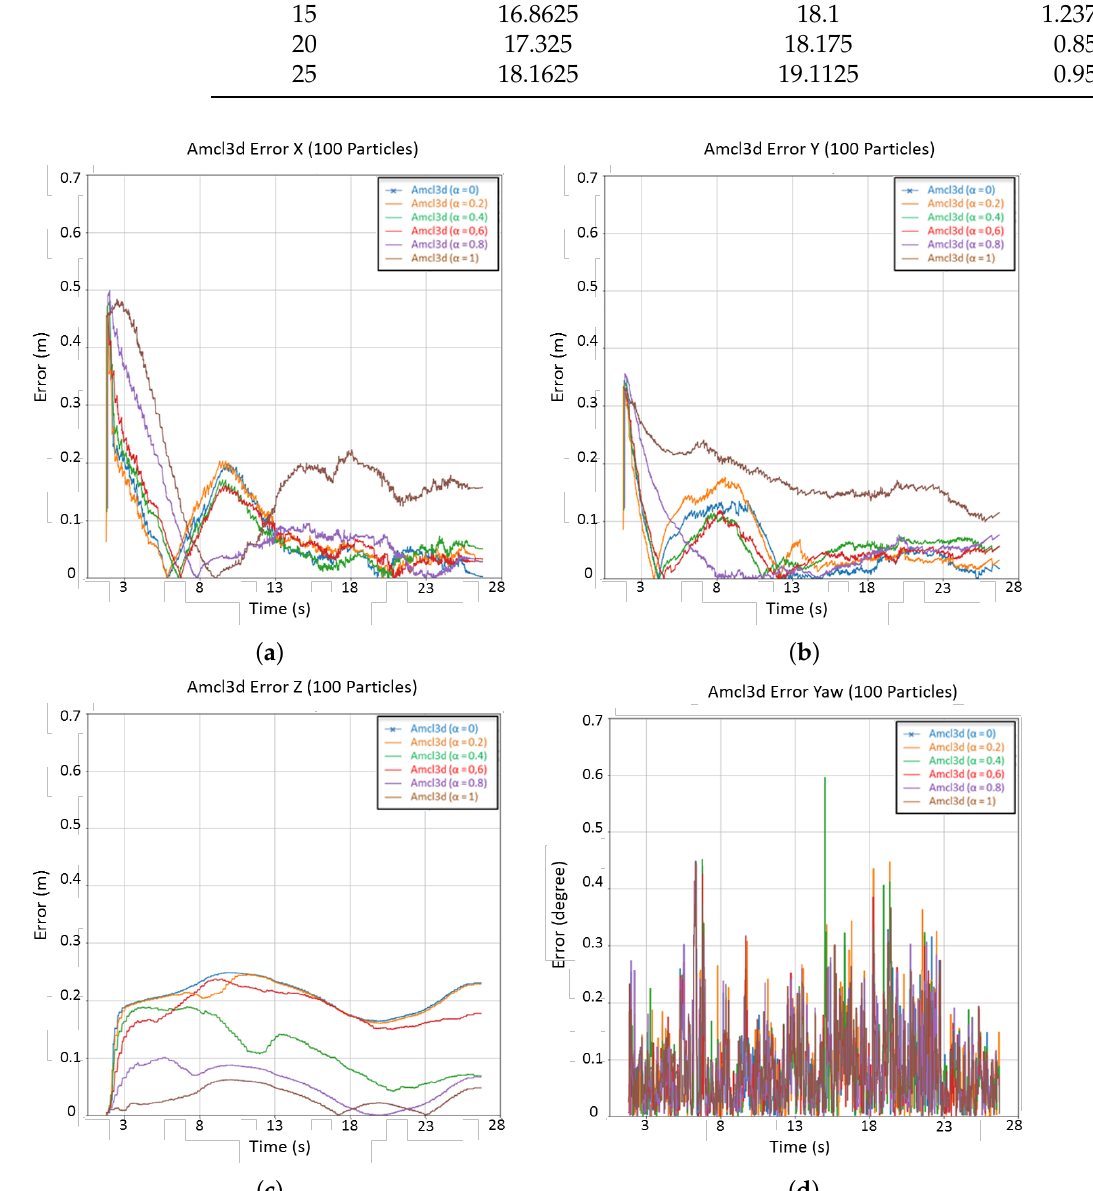
Figure 8. Error plots using 100 particles: ( a ) errors in X, ( b ) errors in Y, ( c ) errors in Z, ( d ) errors in